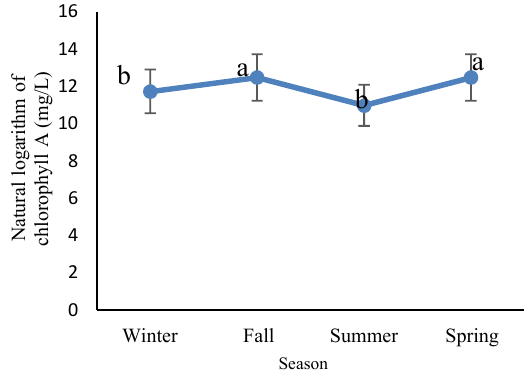
Fig. 1. Mean natural log of chlorophyll-a (mg/m 3 ) in different seasons in Choghakhor wetland